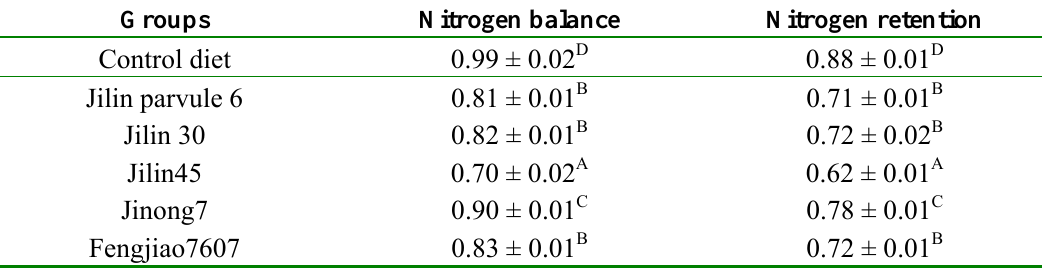
Table 5. Nitrogen balance and nitrogen